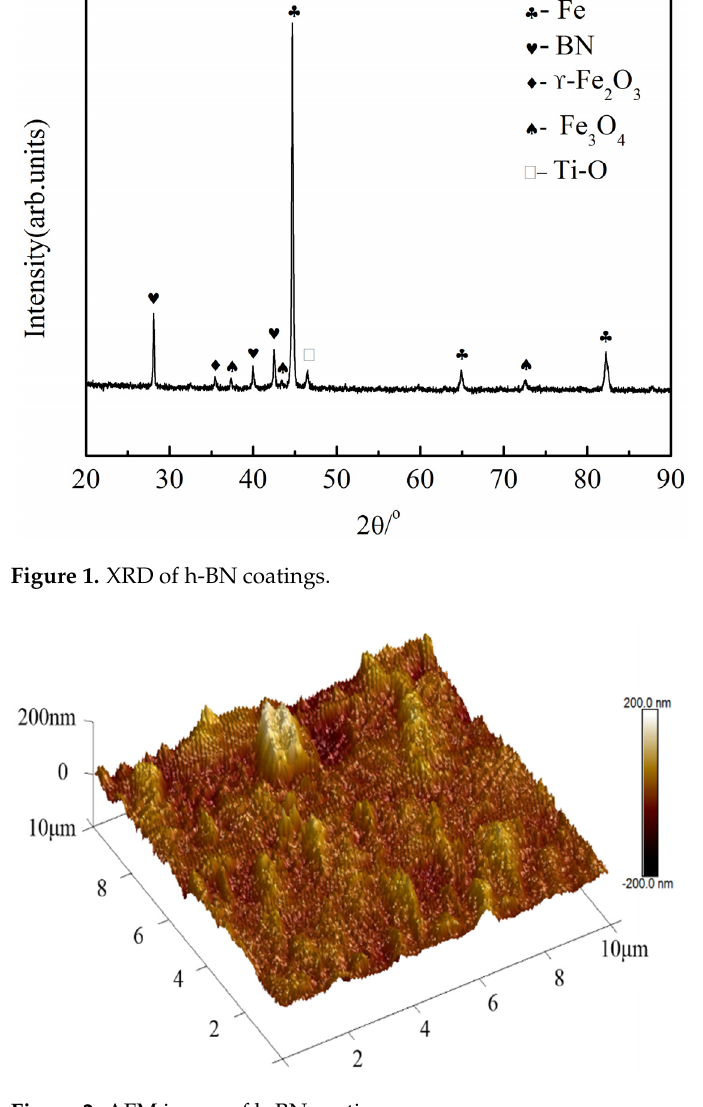
Figure 2. AFM image of h-BN